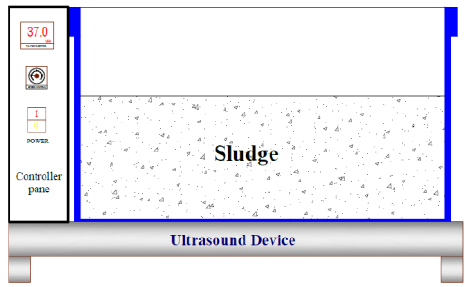
Figure 1. Scheme of sludge pretreatment by ultrasonication.